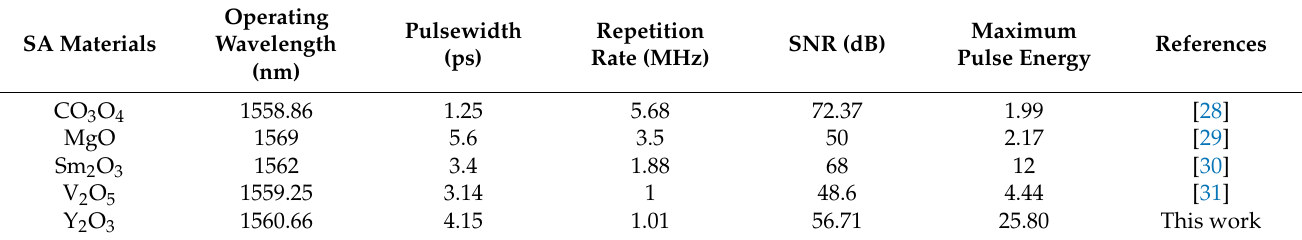
Table 1. Performance comparison of mode-locked fiber lasers with various transition metal oxides (TMOs) saturable absorbers